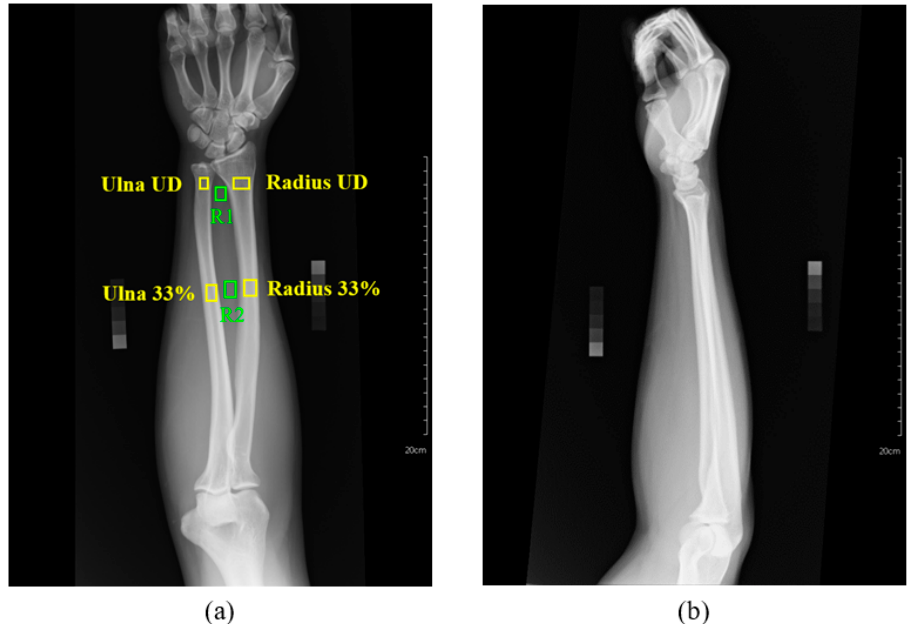
Figure 9. Different views of an adult forearm radiograph. ( a ) anterior-posterior view. Yellow rectangles represent different ROIs. Green rectangles represent the regions for estimating the average brightness of the soft tissues. ( b ) lateral view. Radius UD: ultra distal radius; Ulna UD: ultra distal ulna.